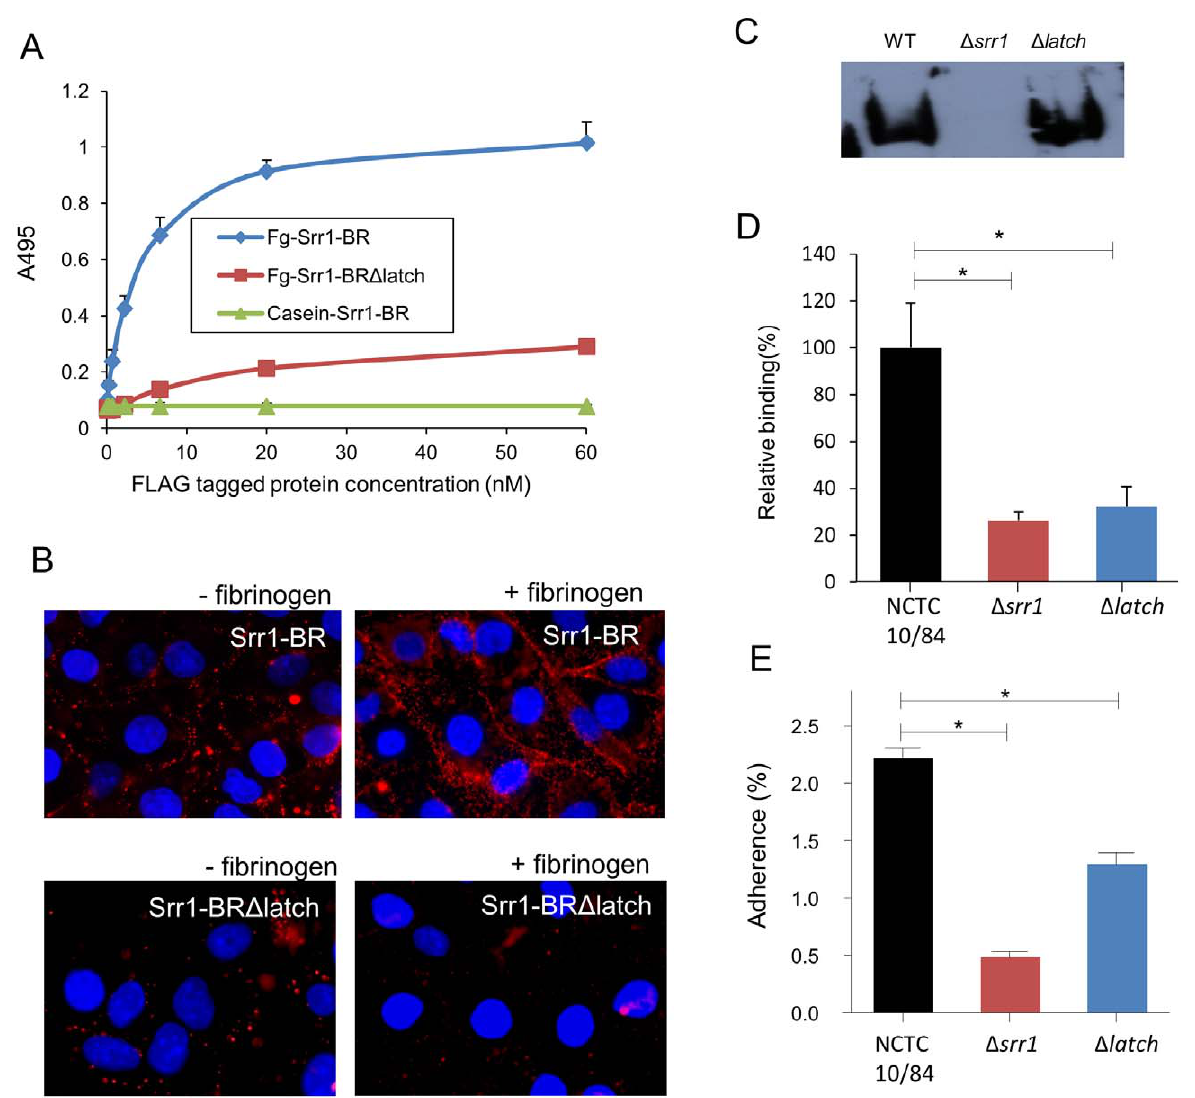
Figure 8. Impact of the Srr1 latch-like domain on GBS binding. (A) Binding of FLAG Srr1-BR and FLAG Srr1-BR D latch proteins to immobilized fibrinogen. Indicated concentration of FLAG Srr1-BR and FLAG Srr1-BR D latch were added to wells coated with fibrinogen or casein blocking reagent. (B) Binding of FLAG Srr1-BR and FLAG Srr1-BR D latch proteins to hBMEC monolayers pretreated with PBS (left panels) or fibrinogen (20 m g/ml, right panels). After washing out unbound proteins, bound proteins were detected with anti-FLAG mAb, followed by Alexa Fluor 488 conjugated anti-mouse IgG (red). Nuclei were stained with DAPI (blue). (C) Expression of Srr1-WT and Srr1 D latch on the cell surface. Isolated cell wall proteins were probed by Western blotting with anti-Srr1 IgG. (D) GBS NCTC 10/84 WT, D srr1 and D latch variant binding to immobilized fibrinogen. Values represent percent of WT GBS binding to fibrinogen. (E) GBS NCTC 10/84 WT, D srr1 and D latch isogenic variant adherence to hBMEC monolayers. *=P , 0.01.